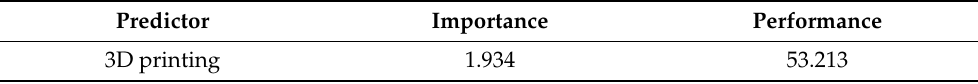
Table 13. Overall effects and importance of 3D